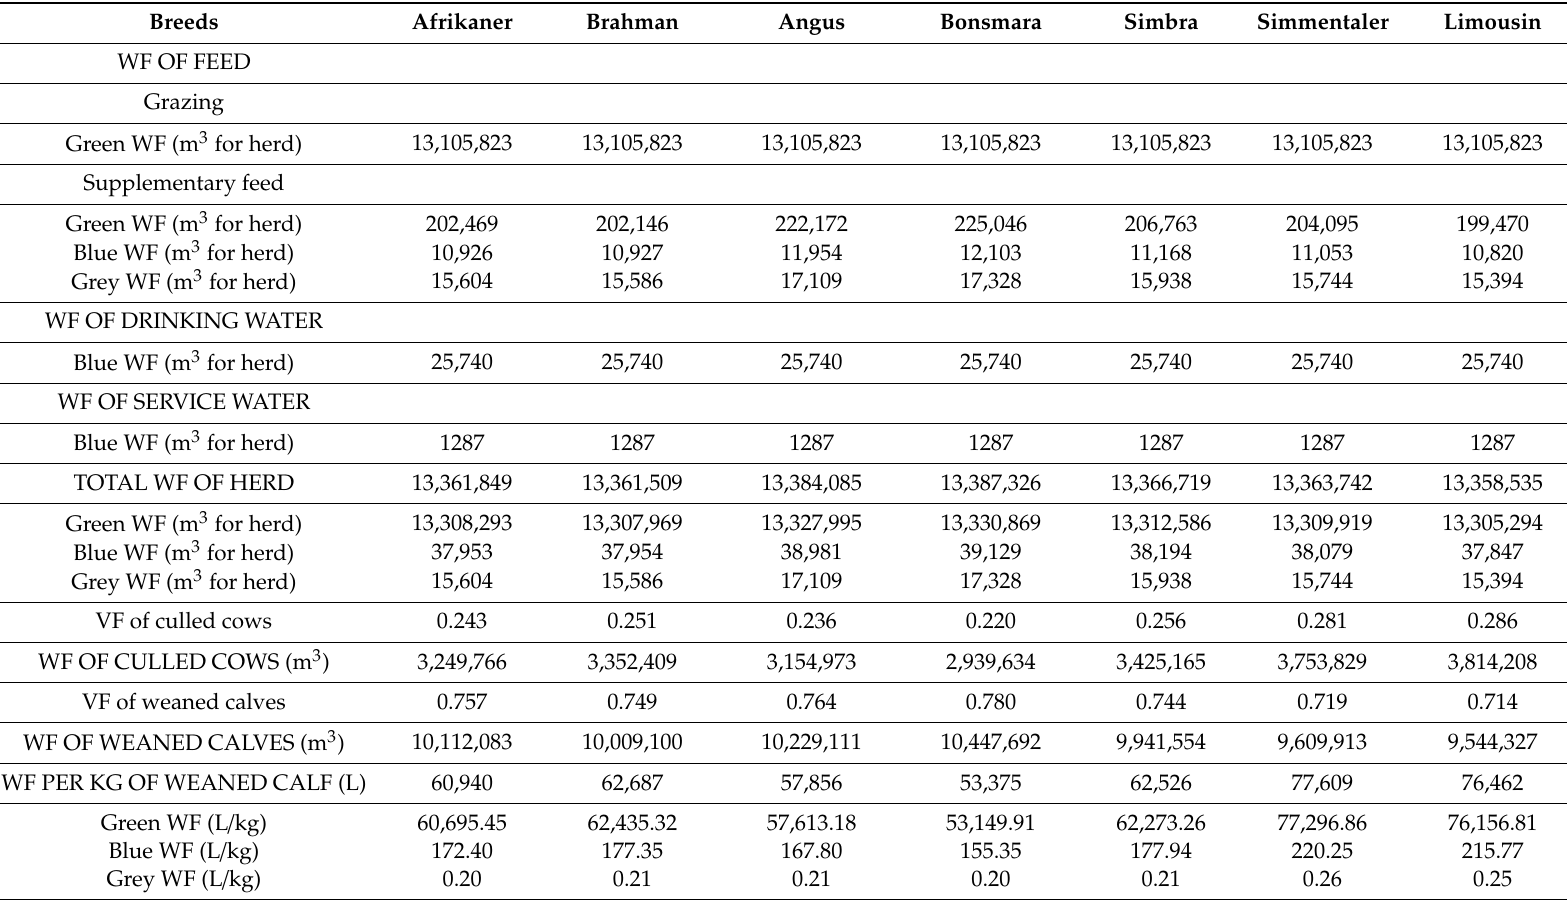
Table 5. The WF of weaned calves and culled cows for the di ff erent breeds. Breeds Afrikaner Brahman Angus Bonsmara Simbra Simmentaler